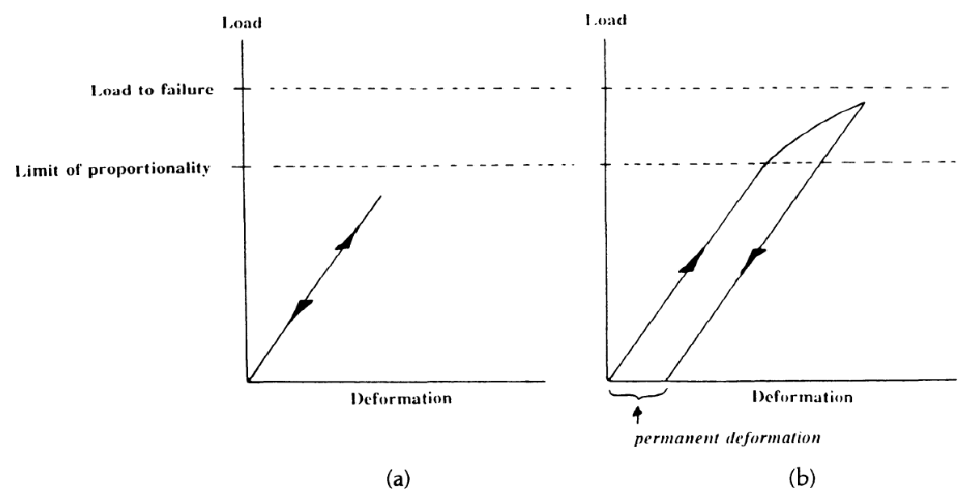
Figure 5. Schematic student textbook plots showing load-deformation paths for ( a ) the elastic (recoverable) and ( b ) the inelastic (irrecoverable) deformation of wood. From [79].